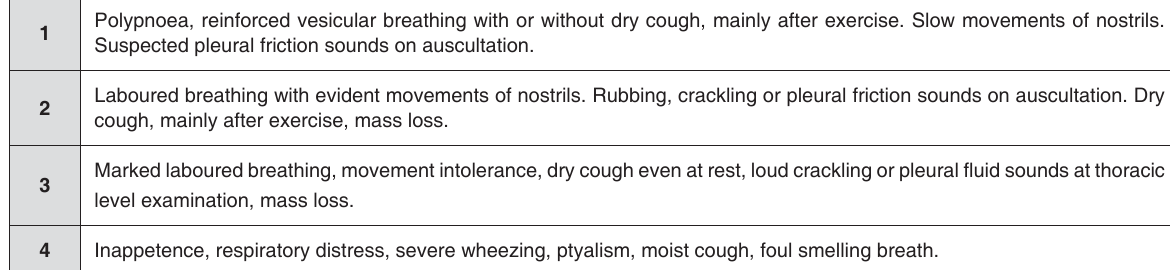
Polypnoea, reinforced vesicular breathing with or without dry cough, mainly after exercise. Slow movements of nostrils. Suspected pleural friction sounds on